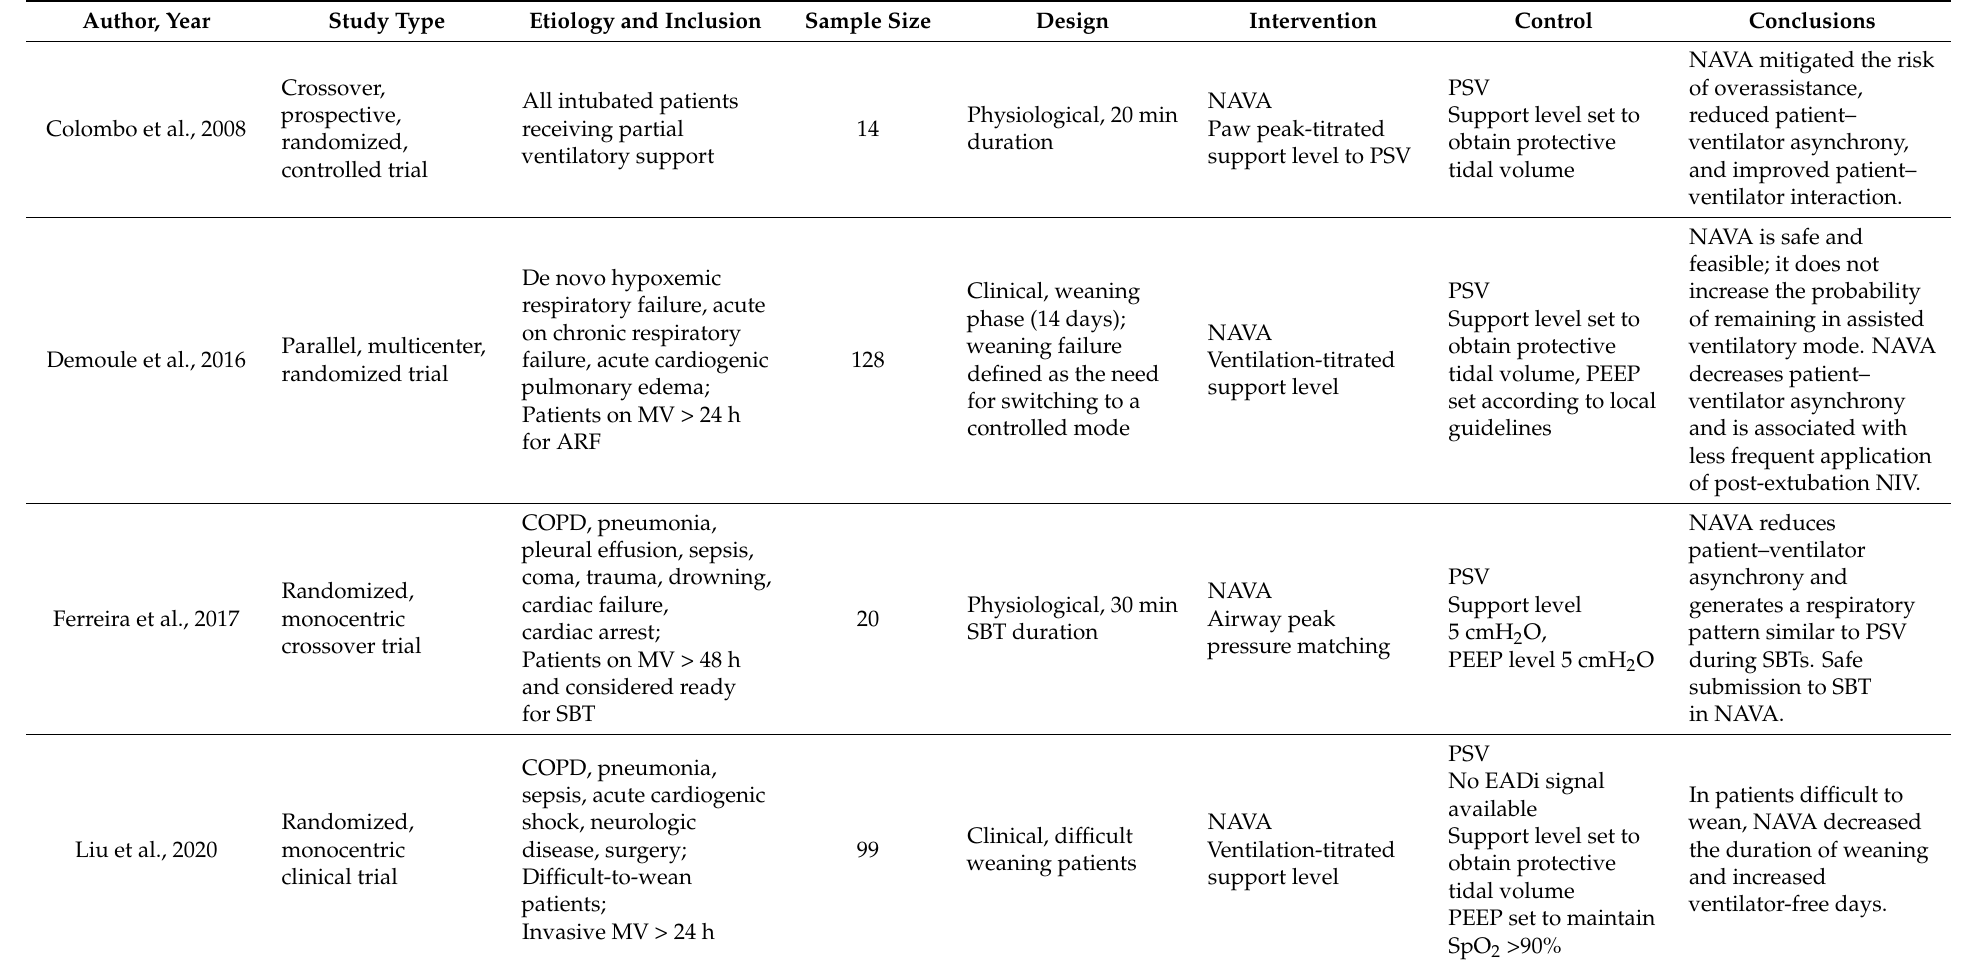
Table 2. Characteristics of the studies included in the systematic